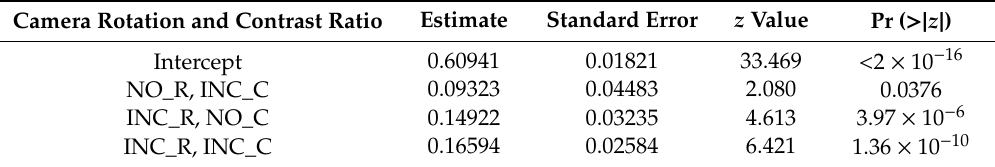
Table 19. Logistic regression analysis results concerning the camera rotation and contrast ratio. Camera Rotation and Contrast Ratio